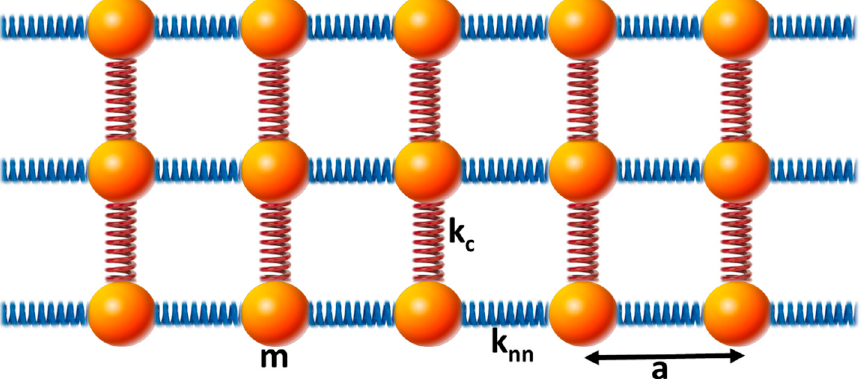
Figure 1. Schematic illustration of the system composed of three coupled one-dimensional elastic waveguides. The red springs couple the three elastic chains identified with blue springs. See text for meaning of symbols.